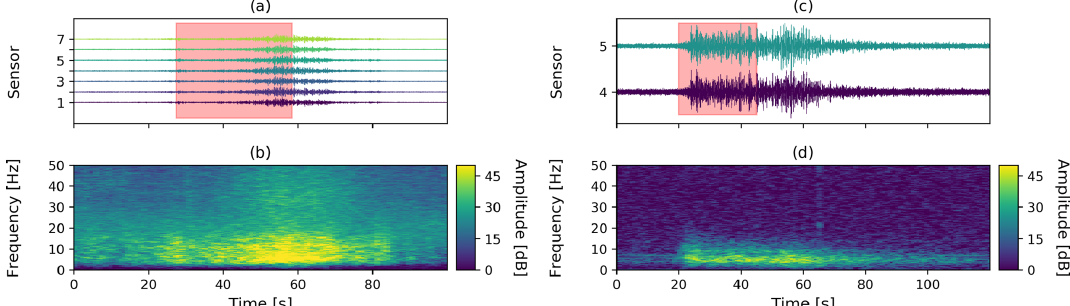
Figure 5. An avalanche released on 9 March 2017 at 06:47LT, and an airplane detected on 28 January 2017 at 09:17LT used as the training event for the classifier. (a) Time series of the avalanche recorded at the seven sensors of the Dischma array, and (b) time series of the airplane recorded at the two working sensors of the Wannengrat array. The red area indicates the section of the time series used as the training event. (b, d) Corresponding average spectrogram of all sensors.